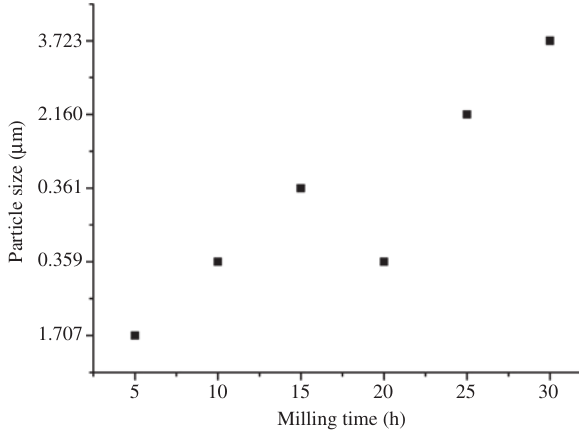
Figure 2 The average particle size of mechanically alloyed powders for different milling time periods.